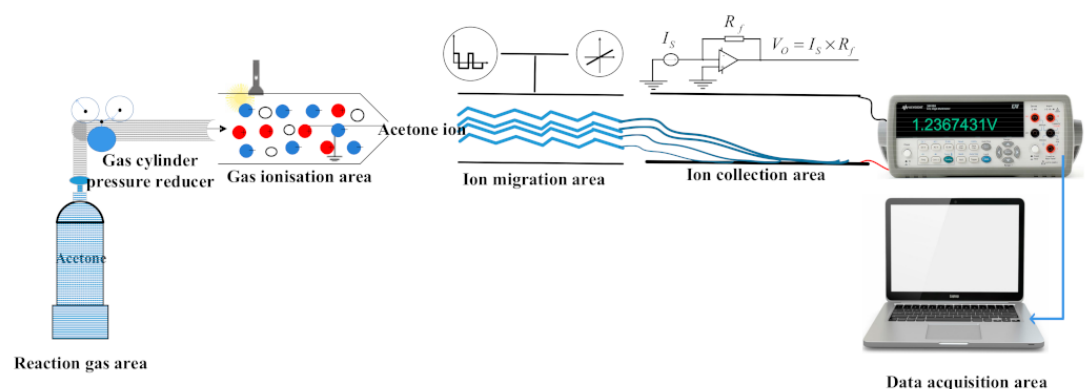
Figure 12. The schematic diagram of the test system.